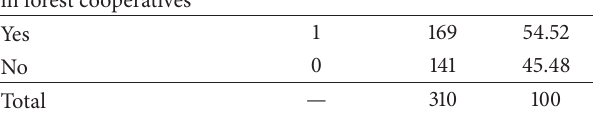
Table 4: Non-industrial family forest landowners’ stated willingness-to-participate in forest